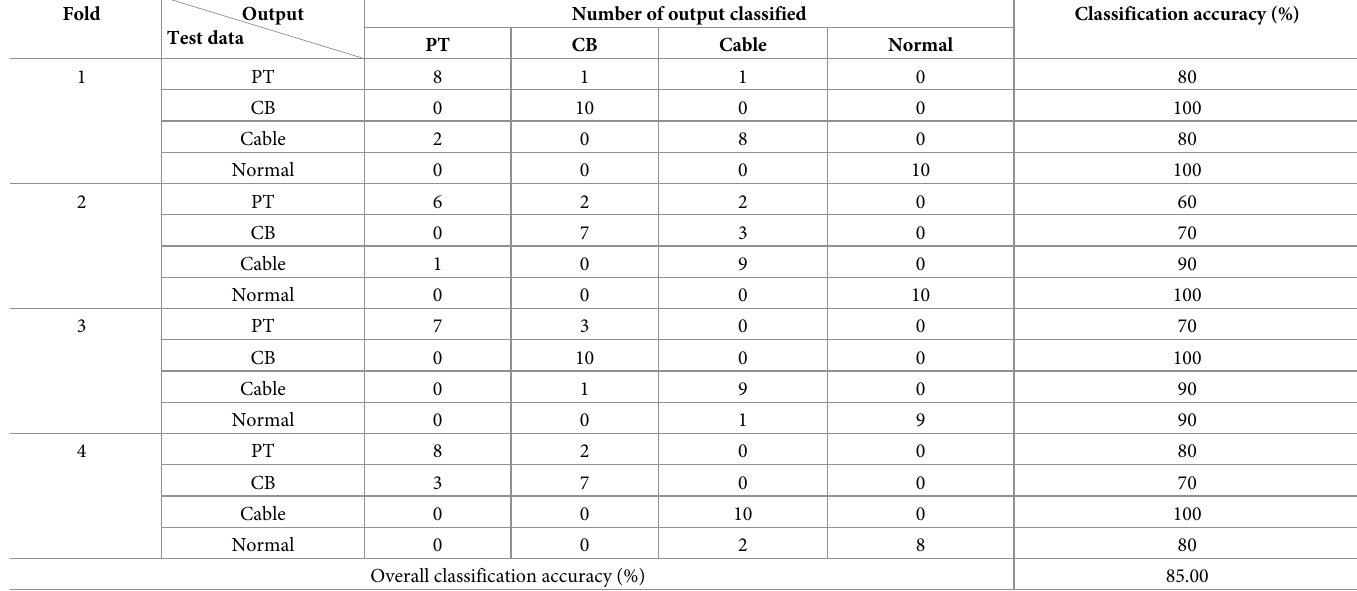
Table 4. Classification results using ANN based on 4-fold cross